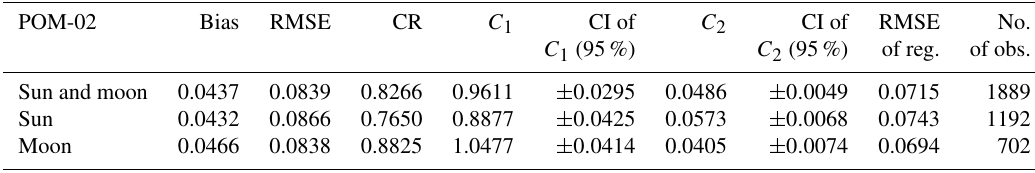
Table 5. Same as Table 4 except for radiosonde and POM-02 precipitable water vapor. POM-02 Bias RMSE CR C 1 CI of C 2 CI of RMSE No. C 1 (95%) C 2 (95%) of reg. of obs. Sun and moon − 0 . 2477 0.3037 0.9946 0.7948 ± 0 . 0138 − 0 . 0057 ± 0 . 0196 0.0658 Sun − 0 . 2206 0.2764 0.9945 0.8041 ± 0 . 0165 − 0 . 0044 ± 0 . 0223 0.0661 Moon − 0 . 3259 0.3726 0.9966 0.7811 ± 0 . 0214 − 0 . 0212 ± 0 . 0343